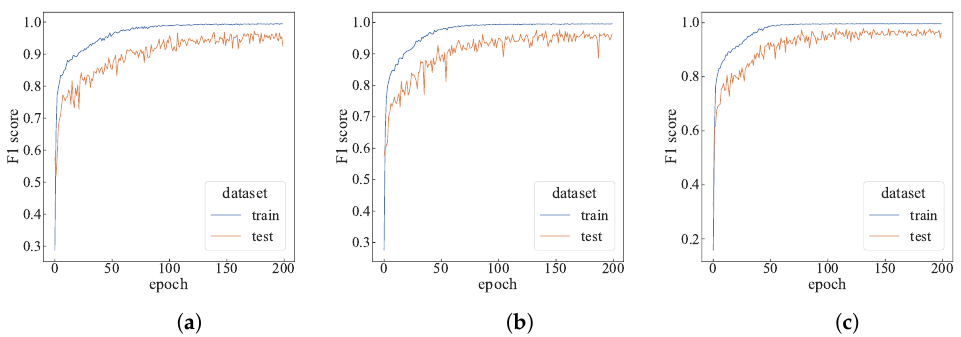
Figure 12. Performance comparison with different trajectory sampling times. ( a ) C = 5; ( b ) C = 7; ( c ) C = 9.